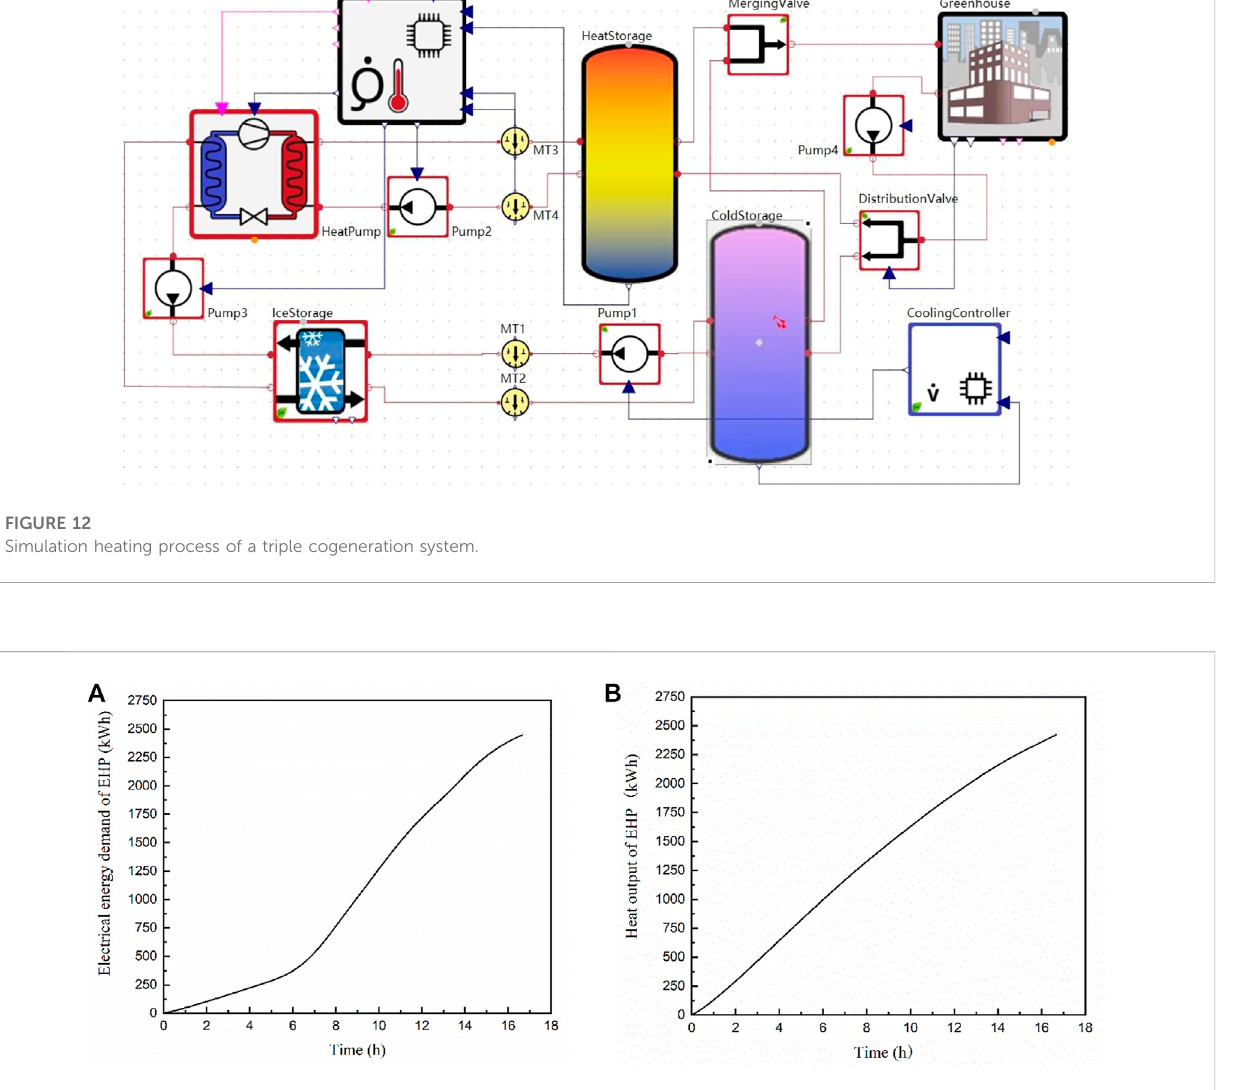
FIGURE 13 Simulationresultsofatriplecogenerationsystem(heatingprocess)with (A) theElectricalenergydemandofanEHPchangeand (B) heatoutputofan EHP